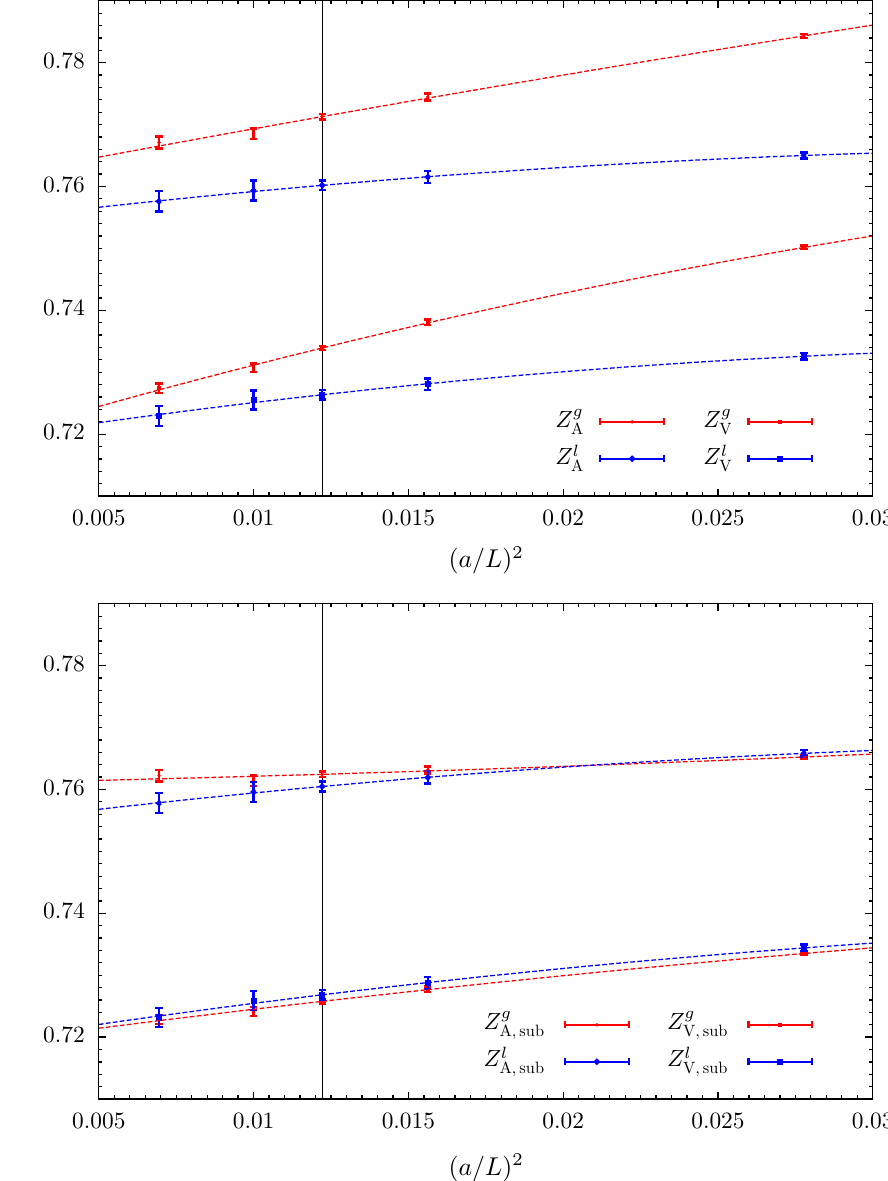
, l /∂ x , where x = ( a / L ) 2 , as a function of β for N A , V